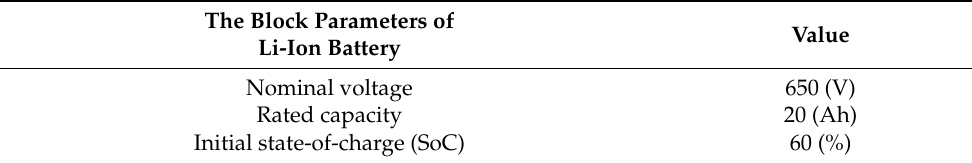
Table 5. The block parameters of the Li-ion battery used as a